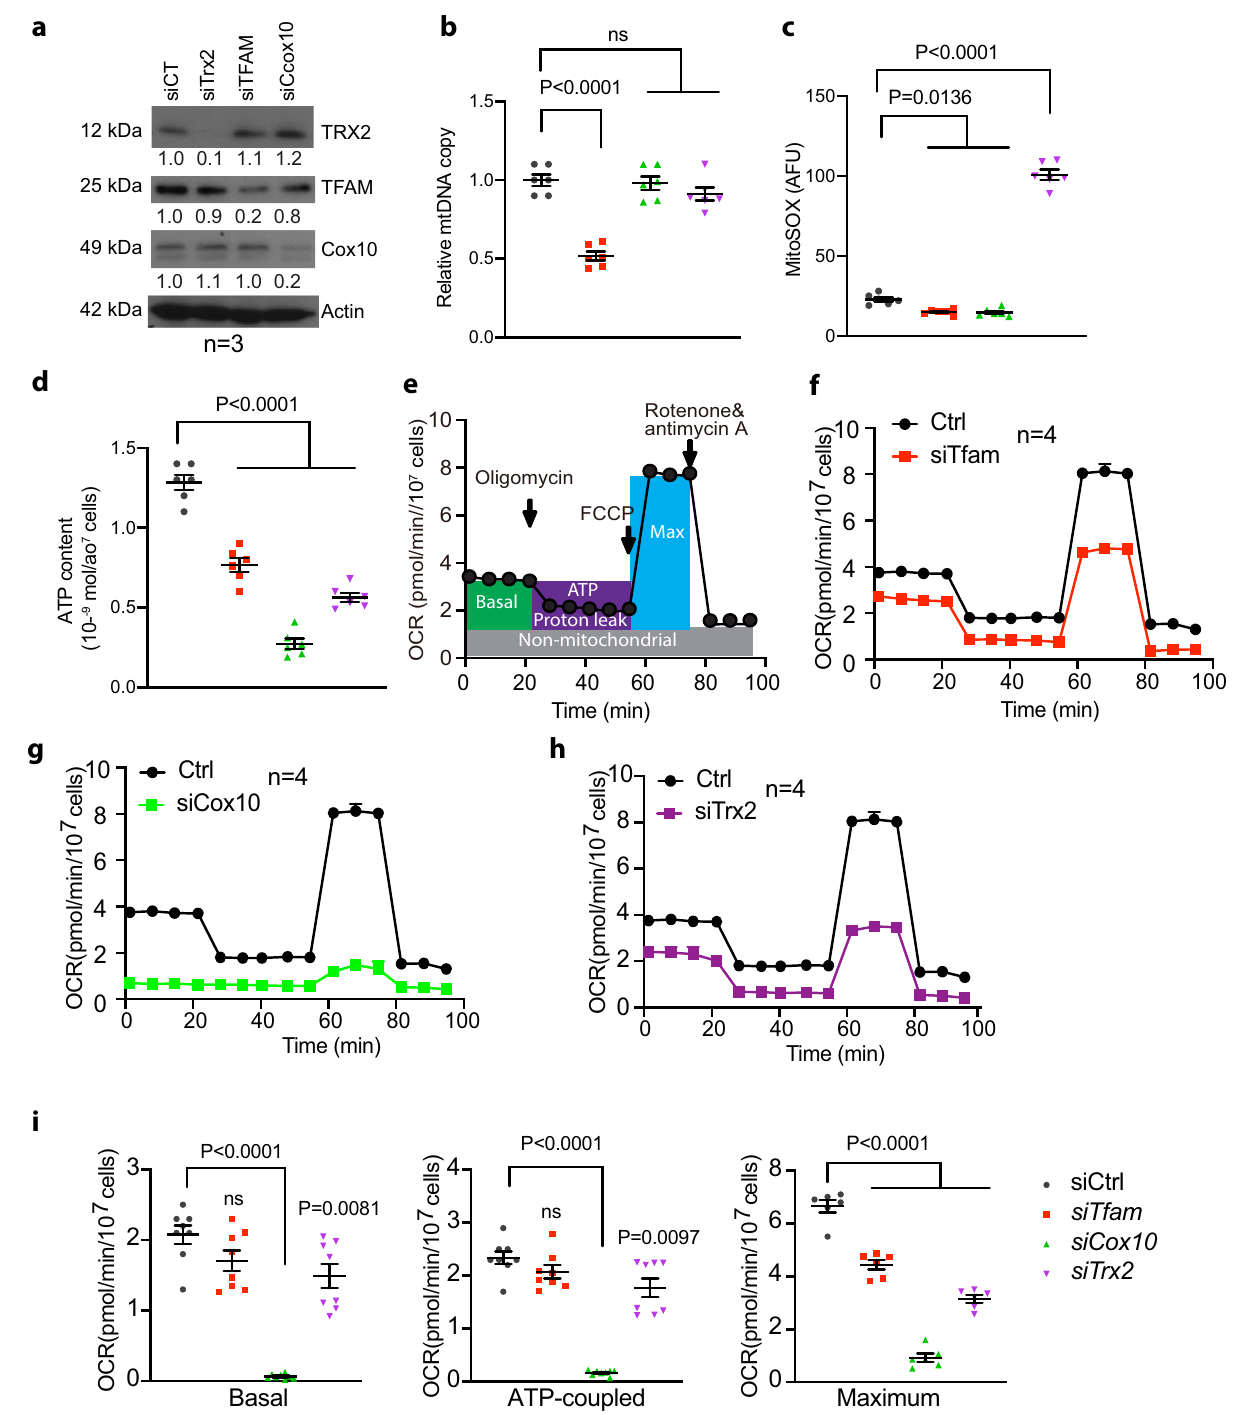
Fig. 1 | Distinct effects of Tfam , Cox10 and Trx2 silencing on mitochondrial function. HUVECsweretransfectedwithcontrol, Tfam , Cox10 or Trx2 siRNAs.48h after transfection, cells were subjected to various assays. a Cell lysates were ana- lyzed by Western blotting for TFAM, COX10 and TRX2 depletion with respective antibodies. Protein levels were quanti fi ed and presented as fold changes by